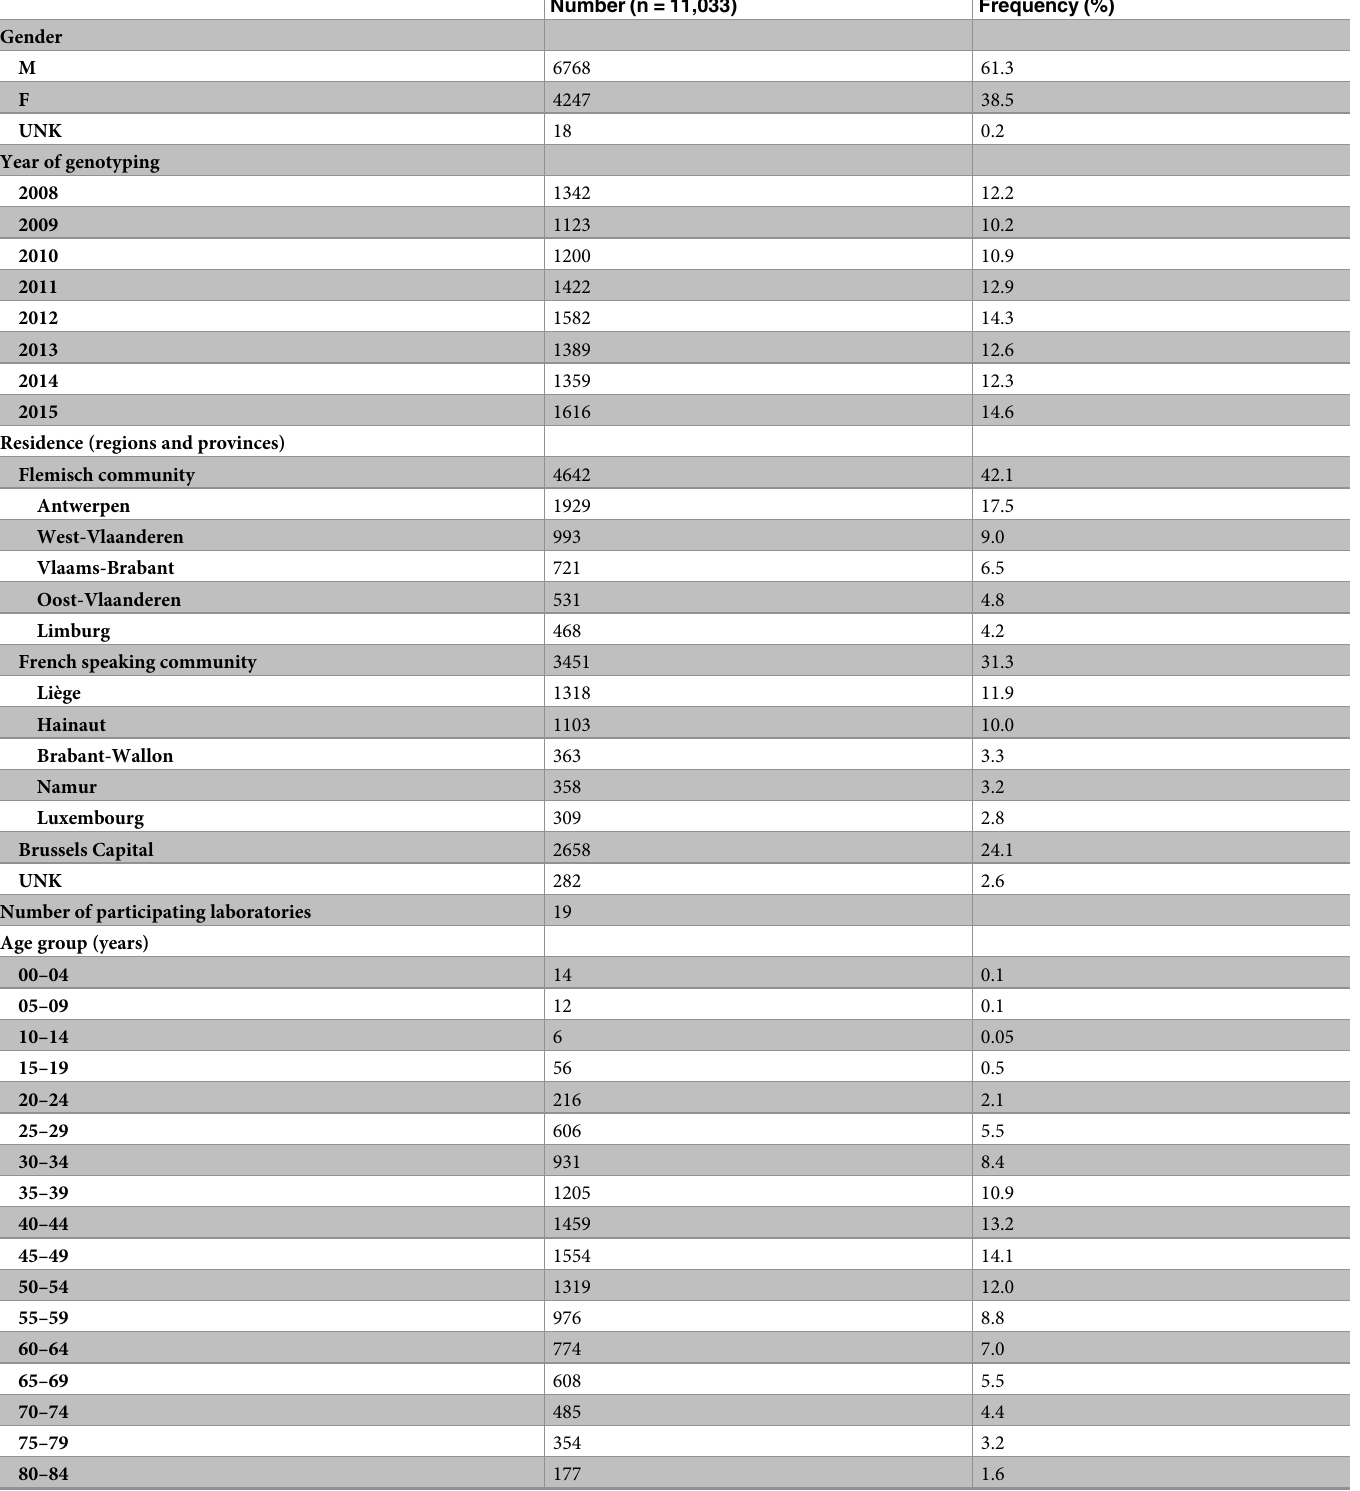
Table 1. Overview of the collected data obtained from the participating laboratories after deduplication of